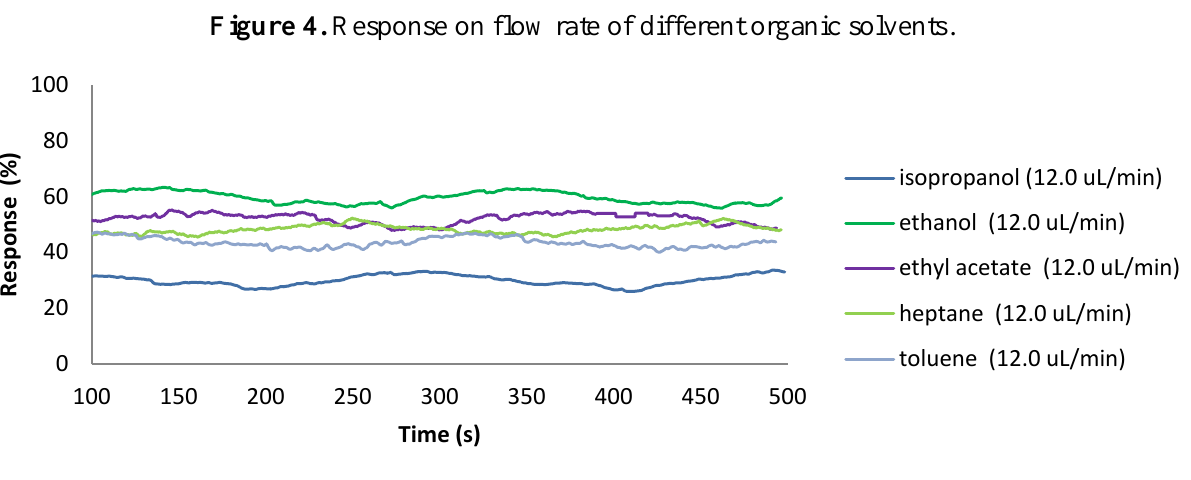
Figure 4. Response on flow rate of different organic solvents.